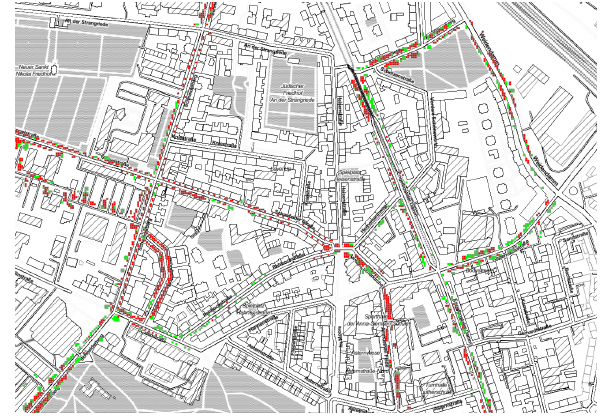
Figure 15. The availability of the space during the requested time period (12 am to 2 pm). Green cells encode free, red cells occupied space (basemap: Stamen